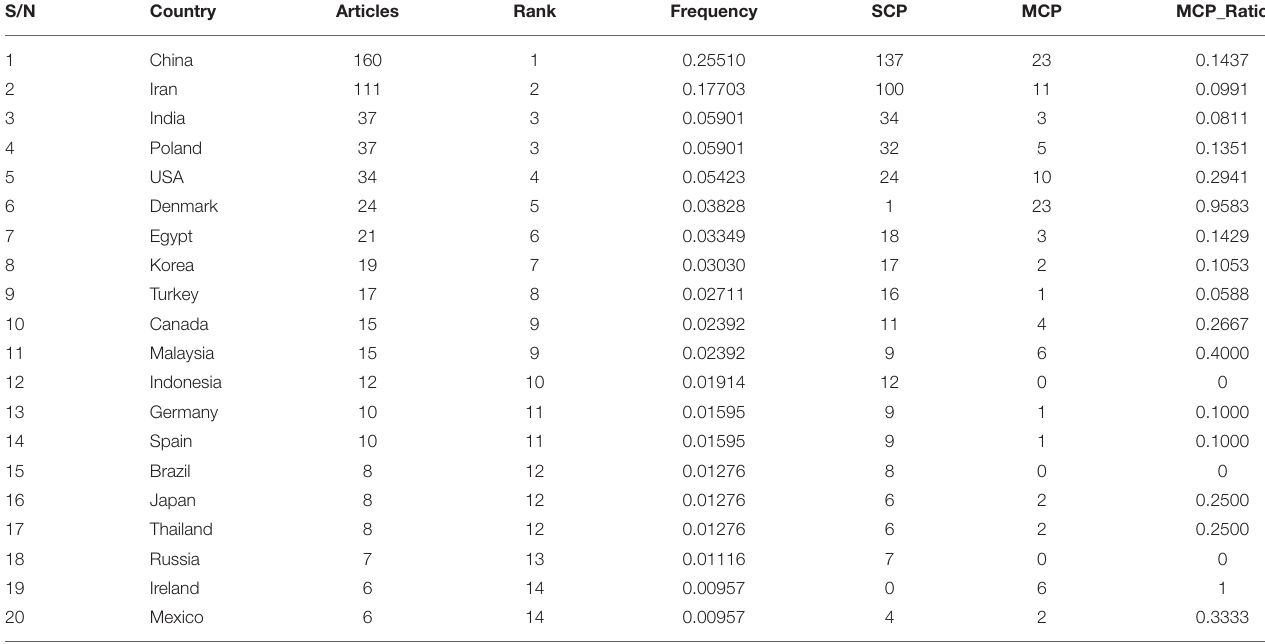
TABLE 3 | The top 20 publications by countries in the field of nanotechnology and meat production research. S/N